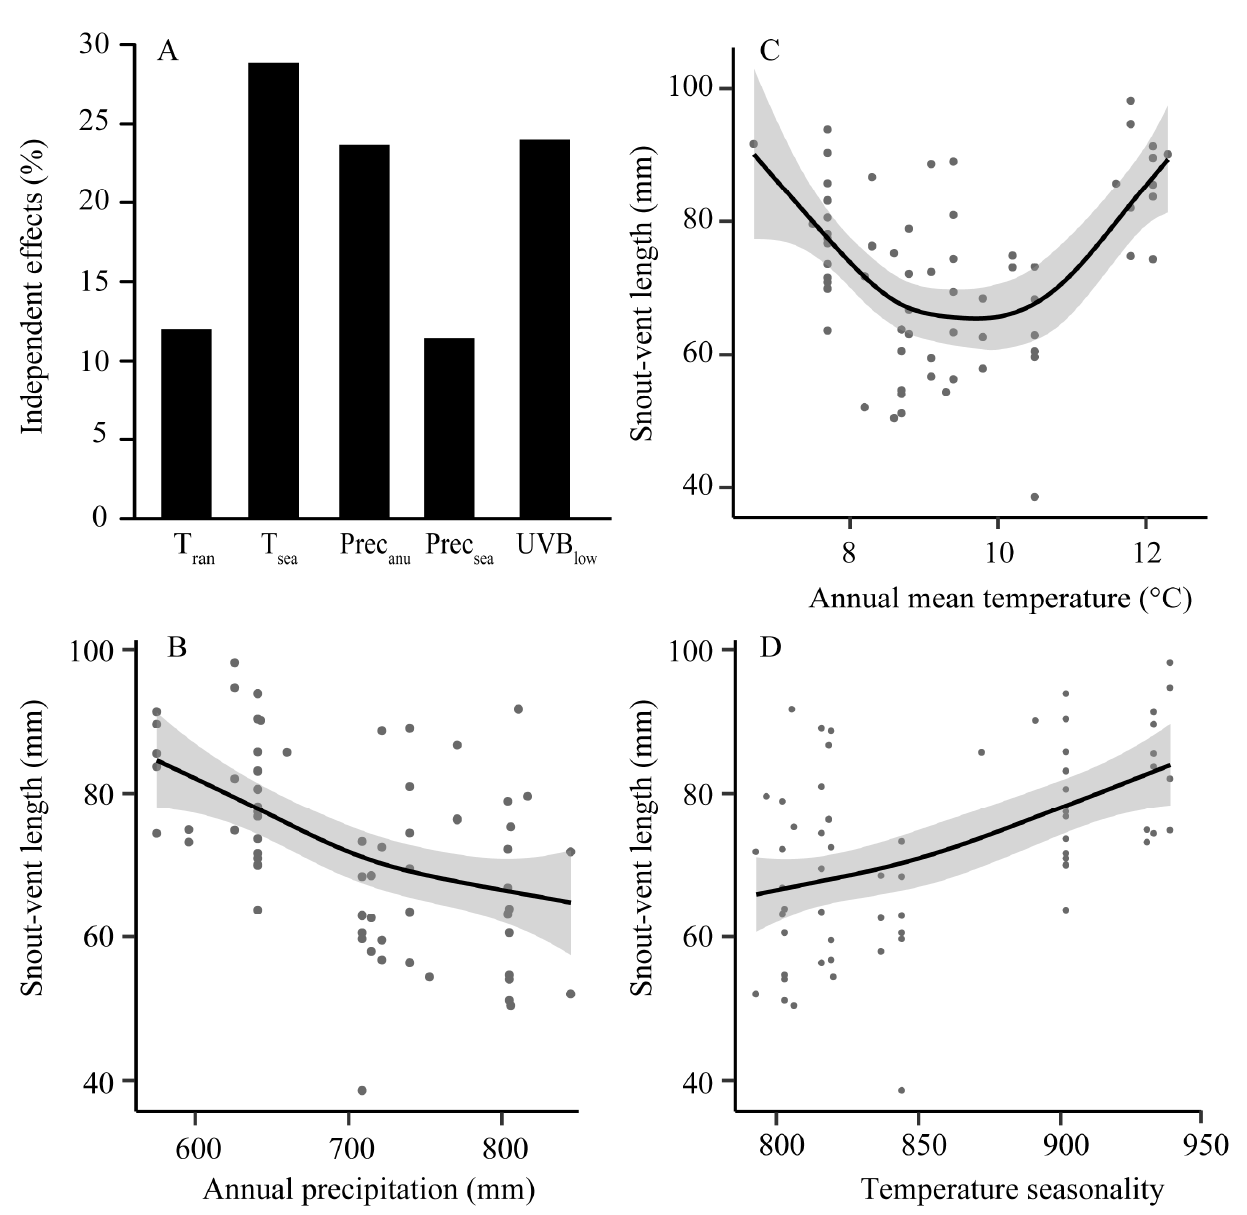
Figure 2. Estimated environmental effects on snout-vent length (SVL). ( A ) Independent contribution for each environmental effect (in percentage) on SVL of Feirana taihangnica based on hierarchical partitioning. T ran : mean monthly temperature range, T sea : temperature seasonality, Prec anu : annual precipitation, Prec sea : precipitation seasonality, and UVB low : mean UV-B of the lowest month; ( B – D ) variation in SVL along different environmental gradients. Illustrations are predicted smoothed regression lines with confidence intervals from generalized additive mixed-effects models.